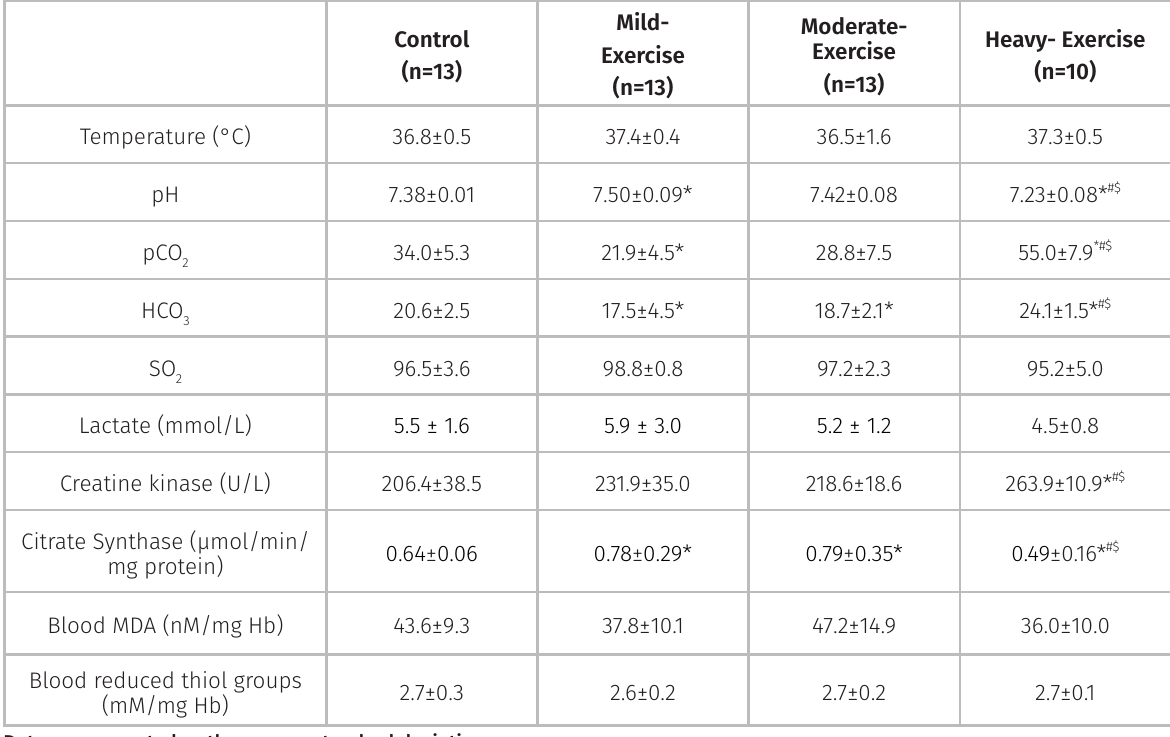
Table II. Maternal metabolic biomarkers of rats submitted to mild, moderate and heavy-exercise intensity during